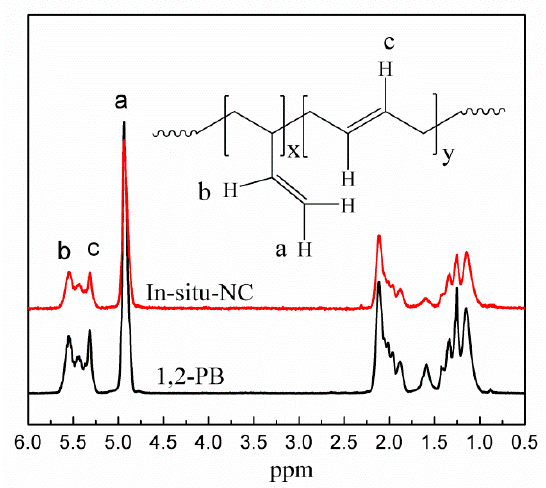
Figure 2. 1 H Nuclear Magnetic Resonance (NMR) spectra of 1,2-PB and in-situ-NC.